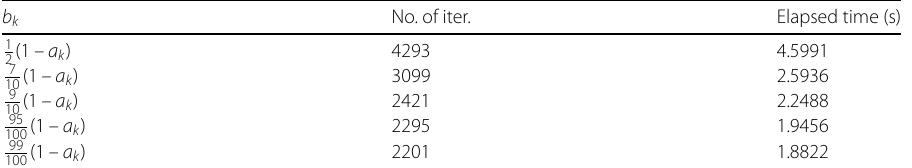
Table 5 Numerical results of b k b